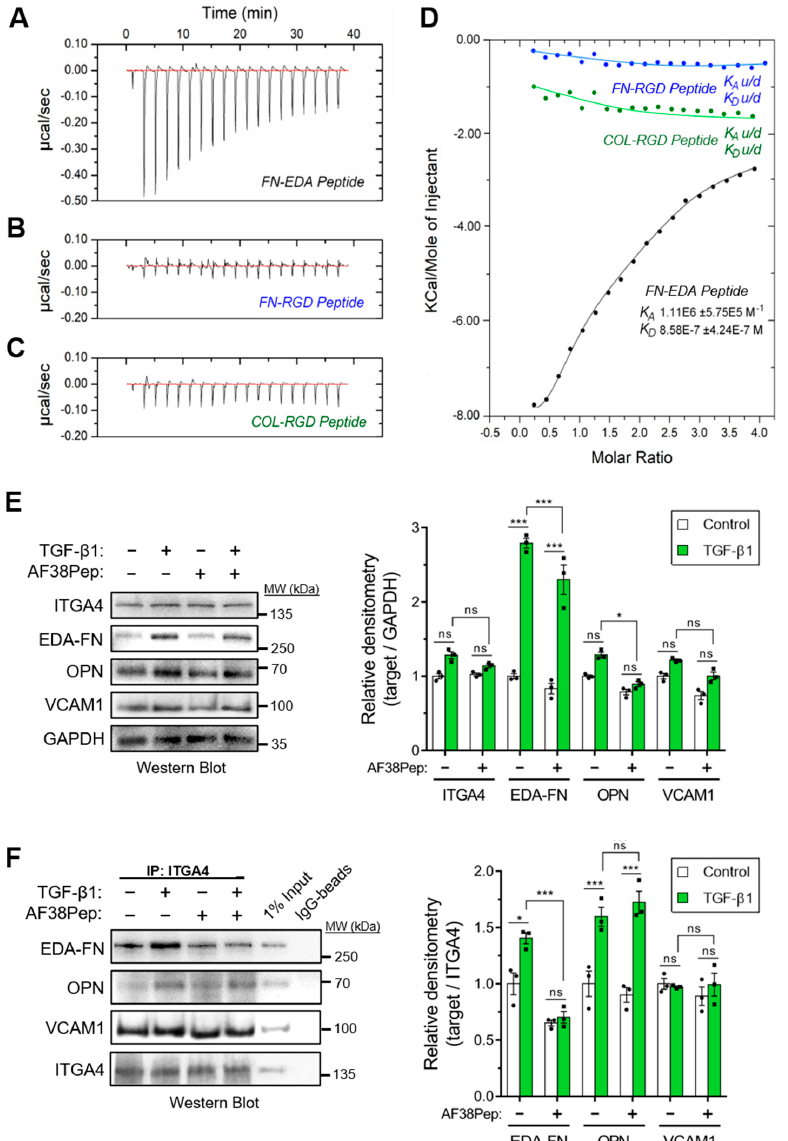
Figure 6. Binding specificity and blocking function of the synthesized blocking polypeptide. The designed blocking peptide was synthesized alongside 3 small test-binding peptides (FN-EDA, FN- RGD, COL-RGD) and were assessed by isothermal calorimetry (ITC), and calorimetric heat traces were used to test whether the blocking peptide has specificity to bind peptides derived from ( A ) the predicted EDA binding ligand (FN-EDA, black), ( B ) the RGD-domain of EDA-FN and FN shown to bind integrin α 4 β 1 / β 7 at a distal site (FN-RGD, blue), and ( C ) the RGD-domain of collagen I previously shown to bind different integrin subunits (COL-RGD, negative control, green). ( D ) The collated isogram is shown alongside predicted dissociation constants ( K D ) and association constants ( K A ), calculated using a 1:1 receptor site to ligand site binding mode. ( E ) Western blot analysis of integrin α 4 protein (ITGA4), EDA-FN, osteopontin (OPN), and vascular cell adhesion protein-1 (VCAM1) total protein following 48 h TGF- β 1, AF38Pep or TGF- β 1+AF38Pep treatments. GAPDH was used as a loading control. Densitometry quantification is shown alongside. ( F ) Co-IP analysis of ITGA4 binding partners (EDA-FN, OPN, and VCAM1) following 48 h TGF- β 1, AF38Pep or TGF- β 1+AF38Pep treatments. Data are representative of three independent experiments and displayed as the mean ± S.E. Statistical analysis is shown as *** p ≤ 0.001, * p ≤ 0.05, and ns = no statistical significance ( p >